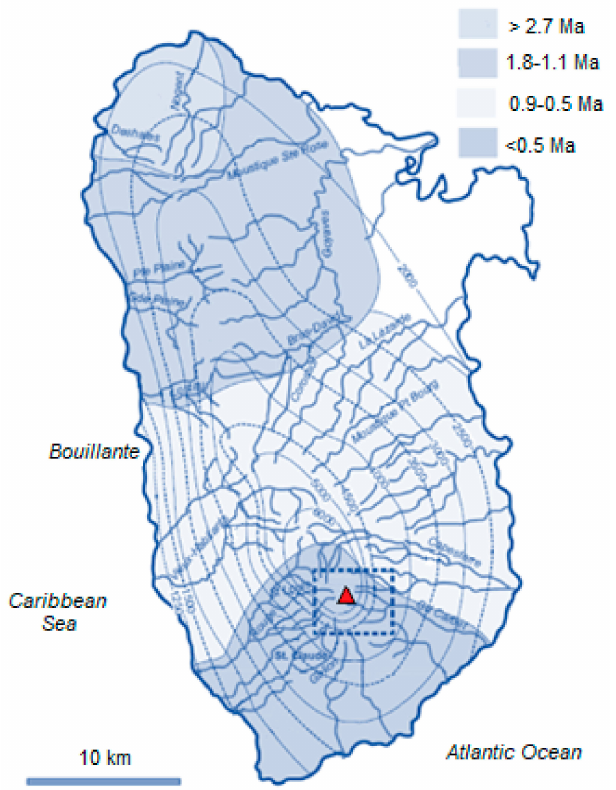
Figure 4. The average spatial distribution of cumulative rainfall in Basse-Terre and its overlap to the river network and different colored fields referring to north–south gradient of the ages of geological formations. The red triangle shows the Soufri è re summit. Modified from Dessert et al. (2015) [55]. The precipitation from one year to the next is strongly impacted by the passage of cyclones, which can produce in one or two days the rainfall equivalent of one to two months: for example, in September 2017 the OVSG rain gauge in Savane à Mulets (1142 m on the Sufri è re southern flank) recorded 440 mm of rainfall in 24 h during the passage of